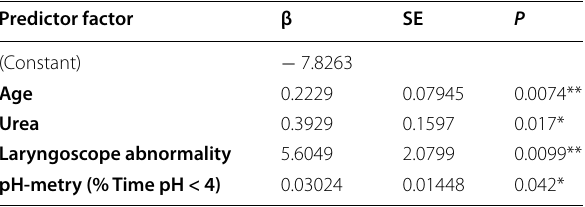
Table 3 Multiple regression model for the factors affecting salivary pepsin using forward